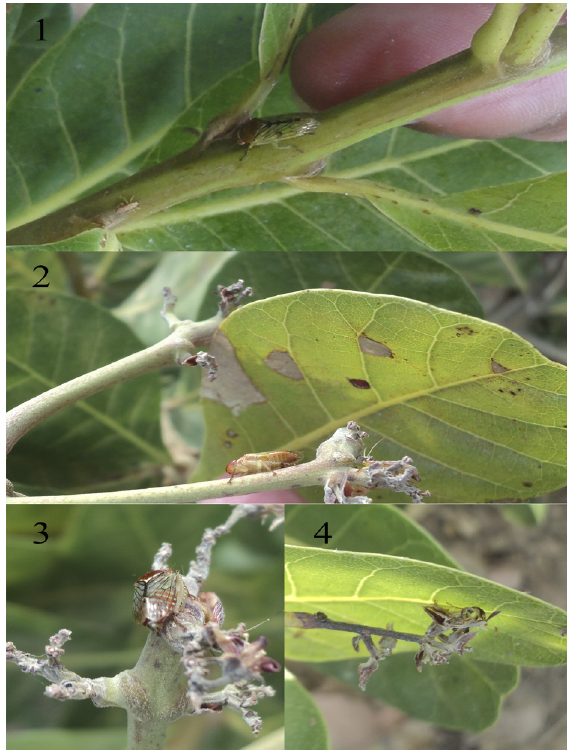
Figure 1-4 - ( 1 ) Female specimen of Gypona cerea feeding on a dwarf cashew tree in Canto do Buriti, PI, Brazil (Source: Vidal Neto FC); ( 2 ) Damage caused by Gypona cerea infesting a crop of dwarf cashew in Canto do Buriti, PI, Brazil; ( 3 ) Male of Gypona cerea feeding on a yellowing branch and an inflorescence showing symptoms of drying; ( 4 ) Totally dried out panicles. (Source: Serrano